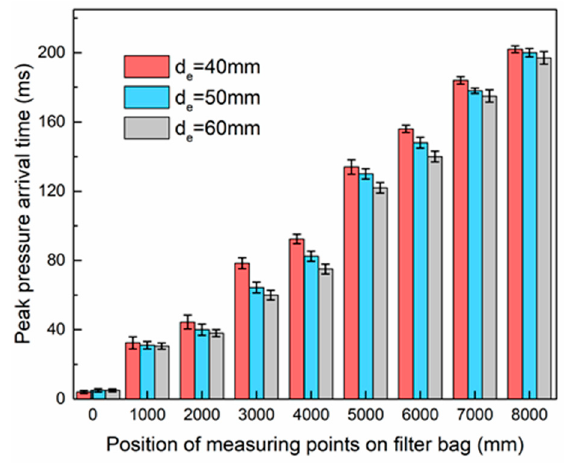
Figure 10. Effect of venturi throat diameter on peak pressure arrival time.